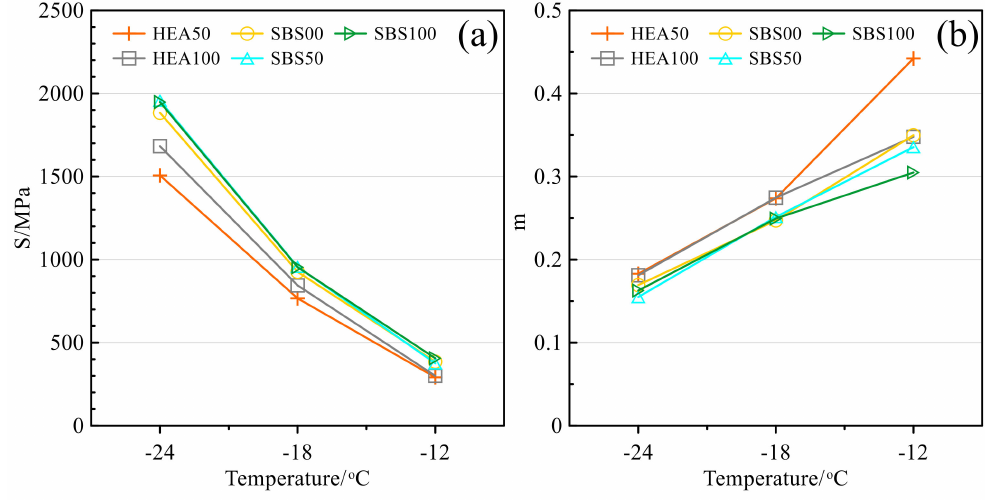
Figure 12. Low-temperature creep of asphalt mastic: ( a ) Creep stiffness. ( b ) Creep